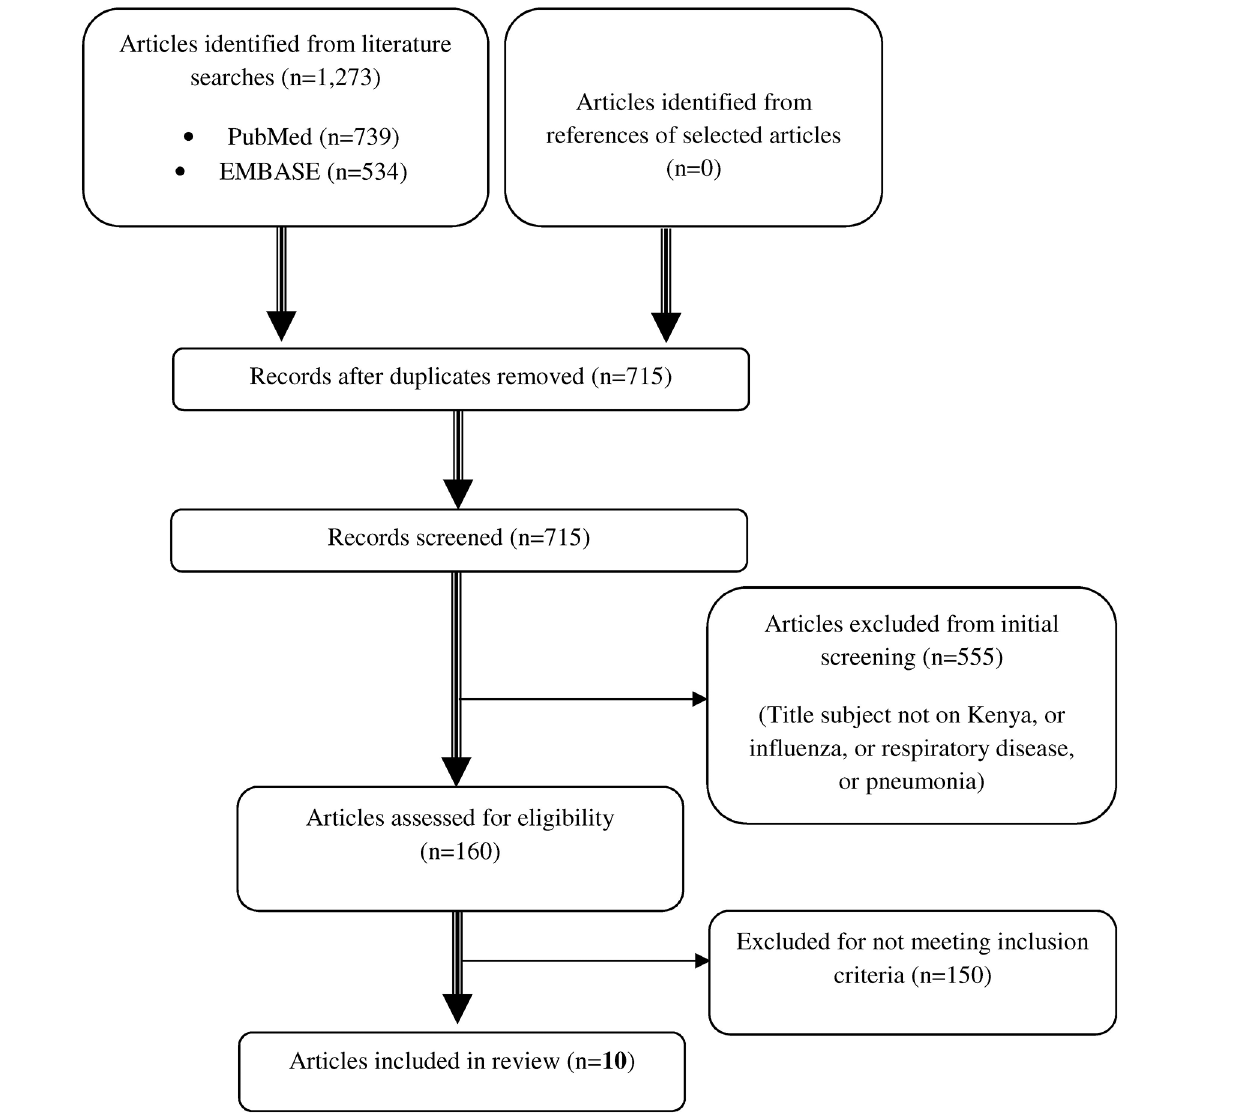
Fig 1. Overview of the different phases of literature